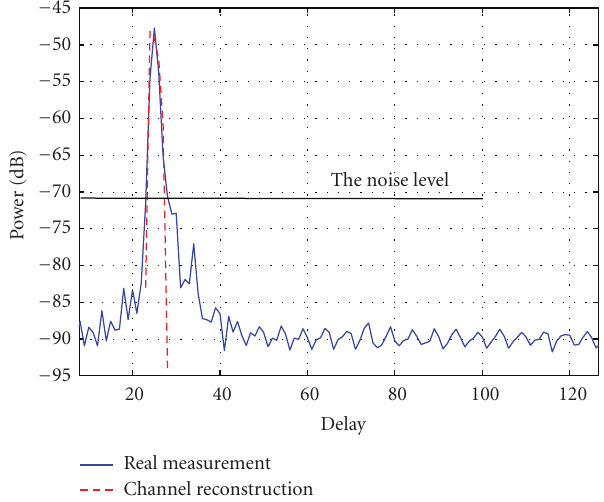
Figure 5: The delay domain response (in dB) of CIRs.